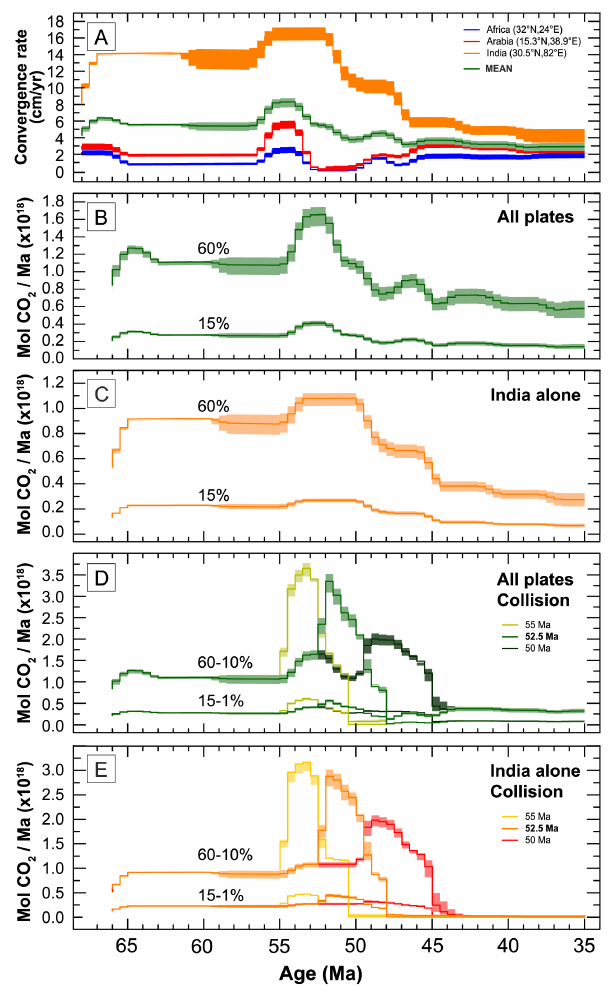
Figure 4. (a) Calculated mean Tethyan subduction rate over the period 65–35Ma, compared with individual subduction rates of Africa, Arabia and India beneath Eurasia. Upper and lower limits of the shaded areas are maximum and minimum velocities, respec- tively, corresponding to points located on the western and eastern syntaxes of each plate. Rates calculated using rotation parameters of van Hinsbergen et al. (2011a, b). (b) Amount of CO 2 produced by the subduction of the Tethys under Eurasia for the same period (green lines), using plate velocities calculated from van Hinsbergen et al. (2011a), for 15 and 60% efficiencies. Upper and lower lim- its of the shaded areas are maximum and minimum gas flux rates computed for each efficiency, respectively. (c) Same as (b) but for Indian only. (d) Same as (b) but including Indian margin subduction at 55, 52.5 and 50Ma. (e) Same as (d) but for India